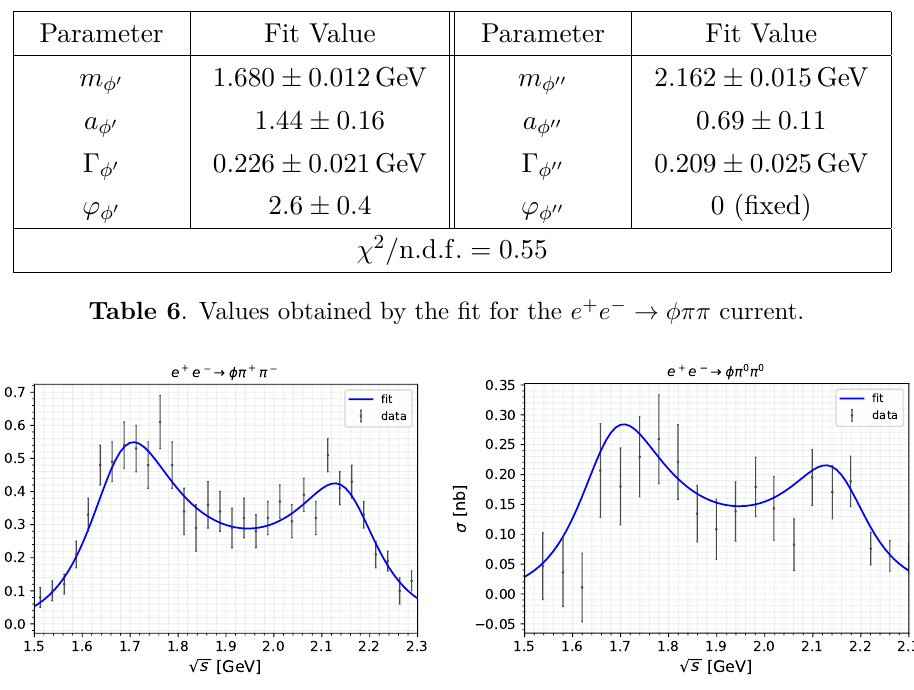
Figure 21 . Cross-section for the charged φπ + π − (left panel) and neutral φπ 0 π 0 (right panel) hadronic final states. The blue curve shows the best fit solution to the cross-section, obtained considering the fit values of table 6. The black points and error bars represent data from [90,